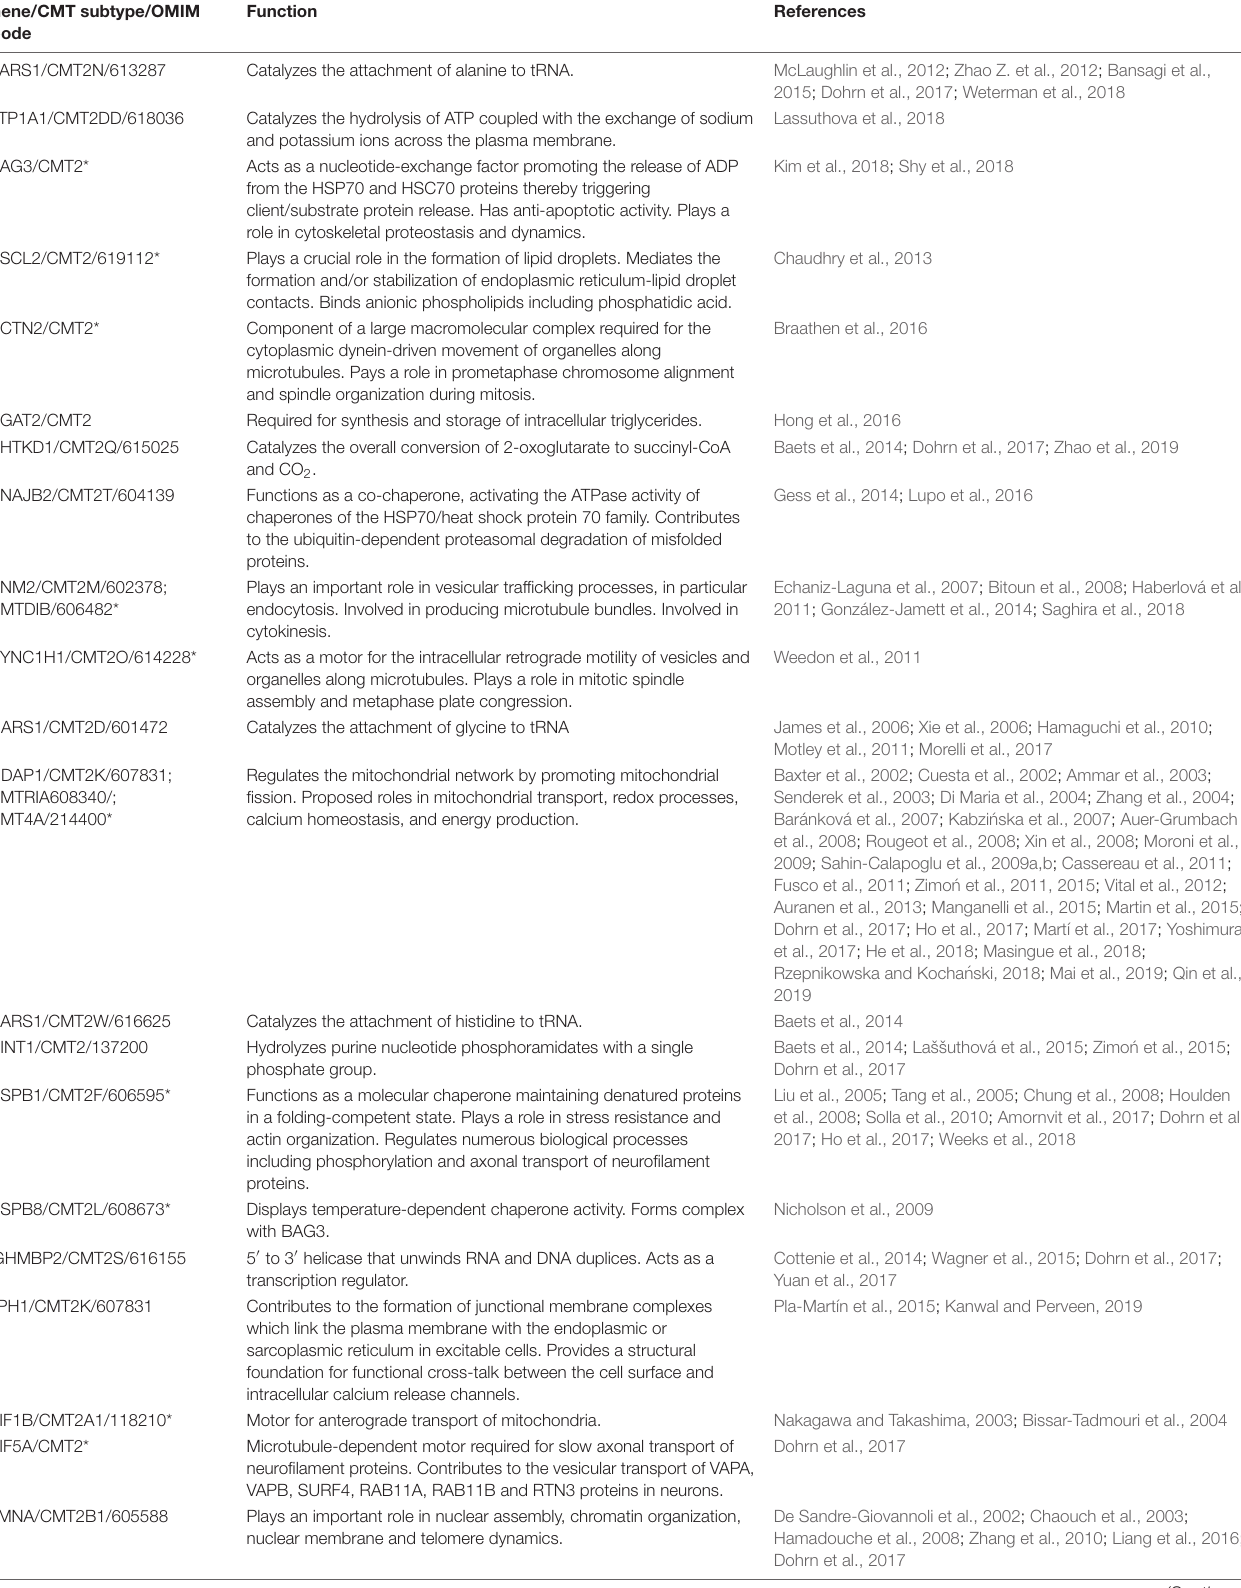
TABLE 1 | Genes mutated in axonal and intermediate